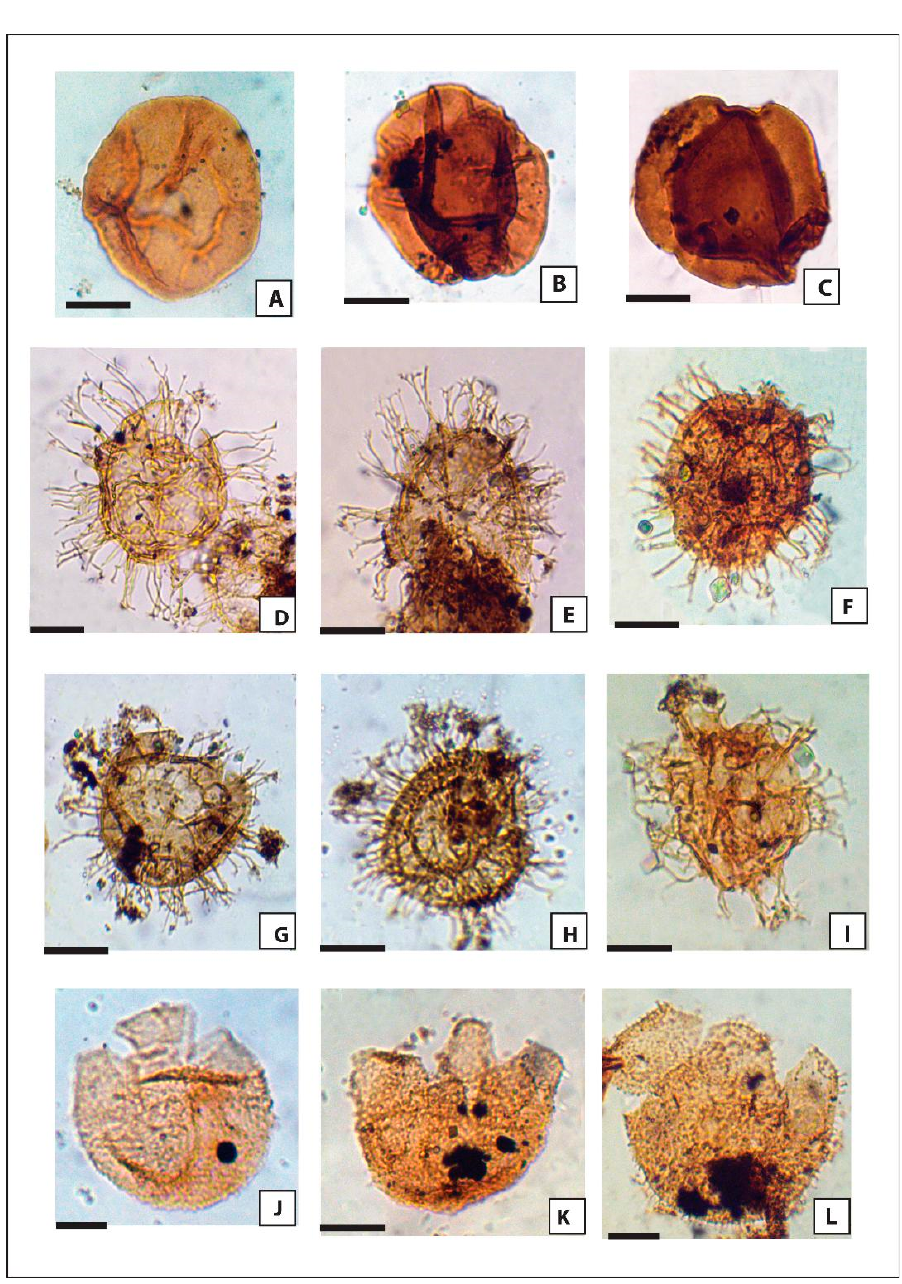
Figure 3. Photomicrographs of the recovered pollen grains and dinoflagellate cysts from the Khatatba Formation taken under transmitted white light. The corresponding well name, sample depth, slide number, and microscope coordinates of the species in the kerogen slides are given. The scale bar is equivalent to 30 µm. ( A ) Araucariacites australis , OBA D-8, 3820 m, slide 1, Coord. 41/11. ( B , C ) Callialasporites trilobatus , OBA D-8, 3810 m, slide 1, Coord. 35.5/11.5; OBA D-10, 3910 m, slide 2, Coord. 55/11. ( D , E ) Systematophora penicillata , Falak-21, 3682 m, slide 2, Coord. 33/10; OBA D-17, 3870 m, slide 1, Coord. 59/5.5. ( F ) Systematophora areolata , THAX-1, 3807 m, slide 1, Coord. 49/11.5. ( G ) Systematophora complicata , OBA D-8, 3790 m, slide 1, Coord. 59/5.5. ( H , I ) Systematophora sp., OBA D-10, 3916 m, slide 2, Coord. 55/10.5; THAX-1, 3777 m, slide 1, Coord. 33/9. ( J , K ) Sentusidinium sp., Falak-21, 3765 m, slide 2, Coord. 34/12; OBA D-17, 3800 m, slide 1, Coord. 41/10. ( L ) Sentusidinium echinatum , OBA D-17, 3830 m, slide 2, Coord.